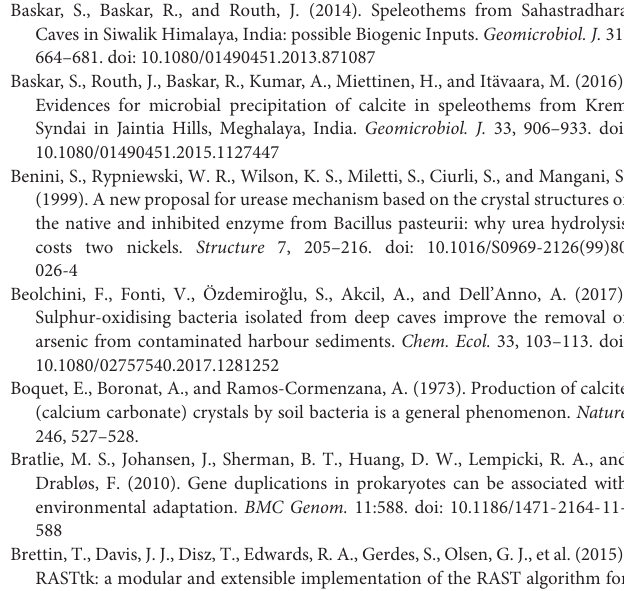
Supplementary Figure 1 | Map of the Iron Curtain Cave demonstrating the location of the two speleothem collection sites. (A) PCS sampling and (B) SSS sampling. Locations are